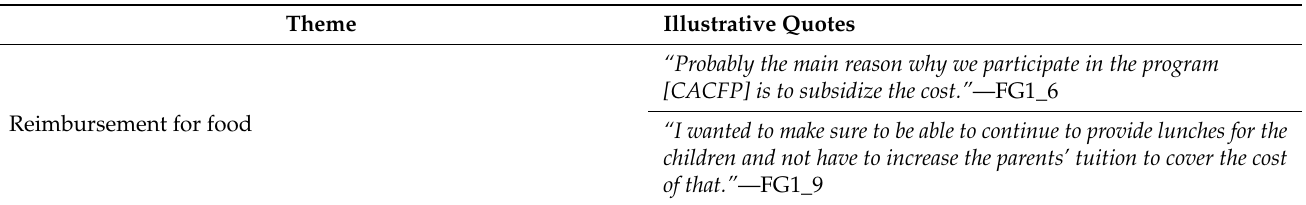
Table 3. Emergent themes of benefits of participating in the Child and Adult Care Food Program (CACFP) 1 .